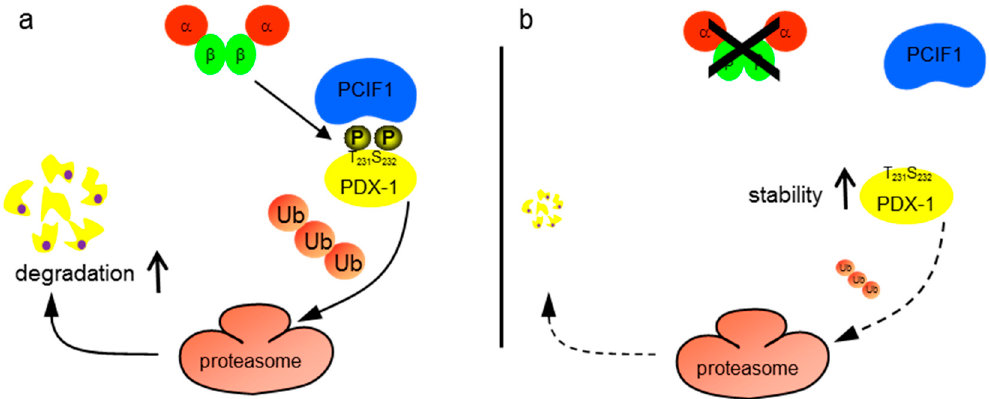
Figure 5. Model of the PDX-1-PCIF1 interaction ( a ) CK2 phosphorylates mouse PDX-1 at threonine 231 and serine 232. This site is located in the middle of a phosphodegron, which binds the E3 ubiquitin ligase protein PCIF1 in a phosphorylated form. PCIF1 targets PDX-1 to the proteasome where it is ubiquitinated and subsequently degraded; and ( b ) upon CK2 inhibition, T231 and S232 of PDX-1 are not phosphorylated. As these important residues of the phosphodegron are not phosphorylated, the interaction with PCIF1 is reduced and PDX-1 is more stable.